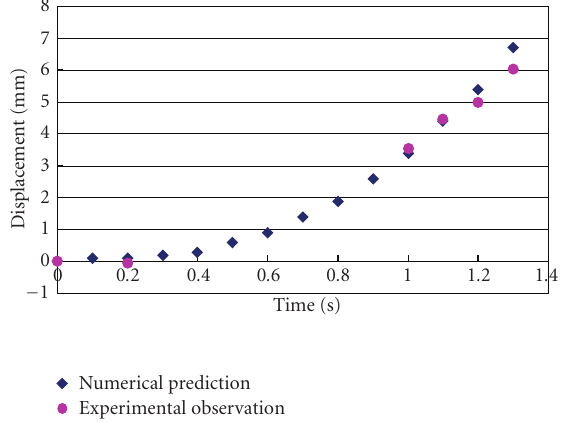
Figure 6: Displacement of position at S6 during inspiration.